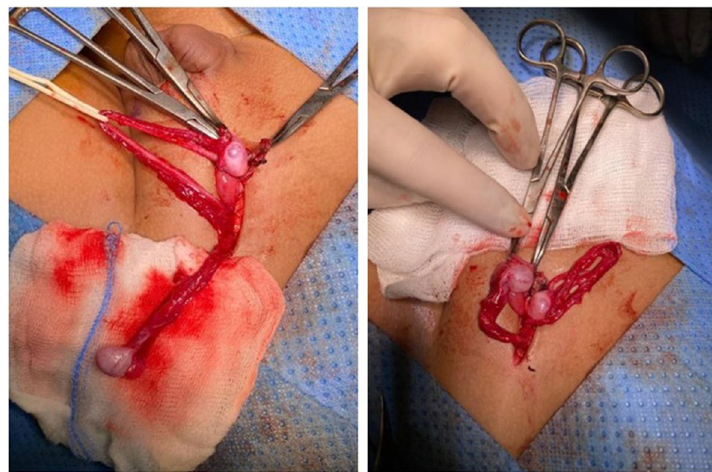
Fig. 2 During the surgery, we found a left indirect inguinal hernia along with two testes in the left scrotum. Superior testis was larger in size and was without epididymis or vas deferens but had a normal blood supply. The inferior testis was smaller in size and had an epididymis along with